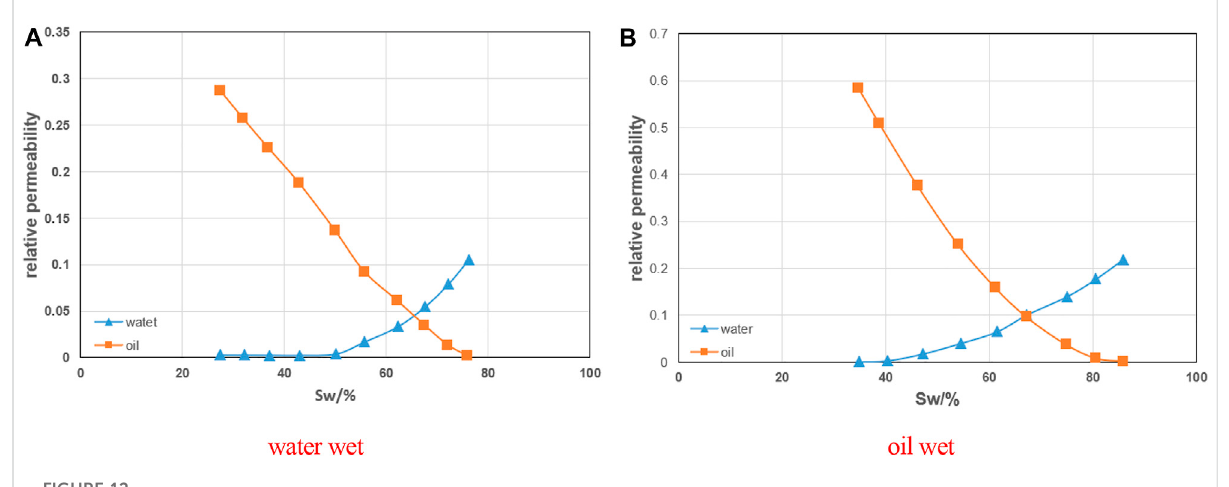
FIGURE 12 The relative permeability curves of different